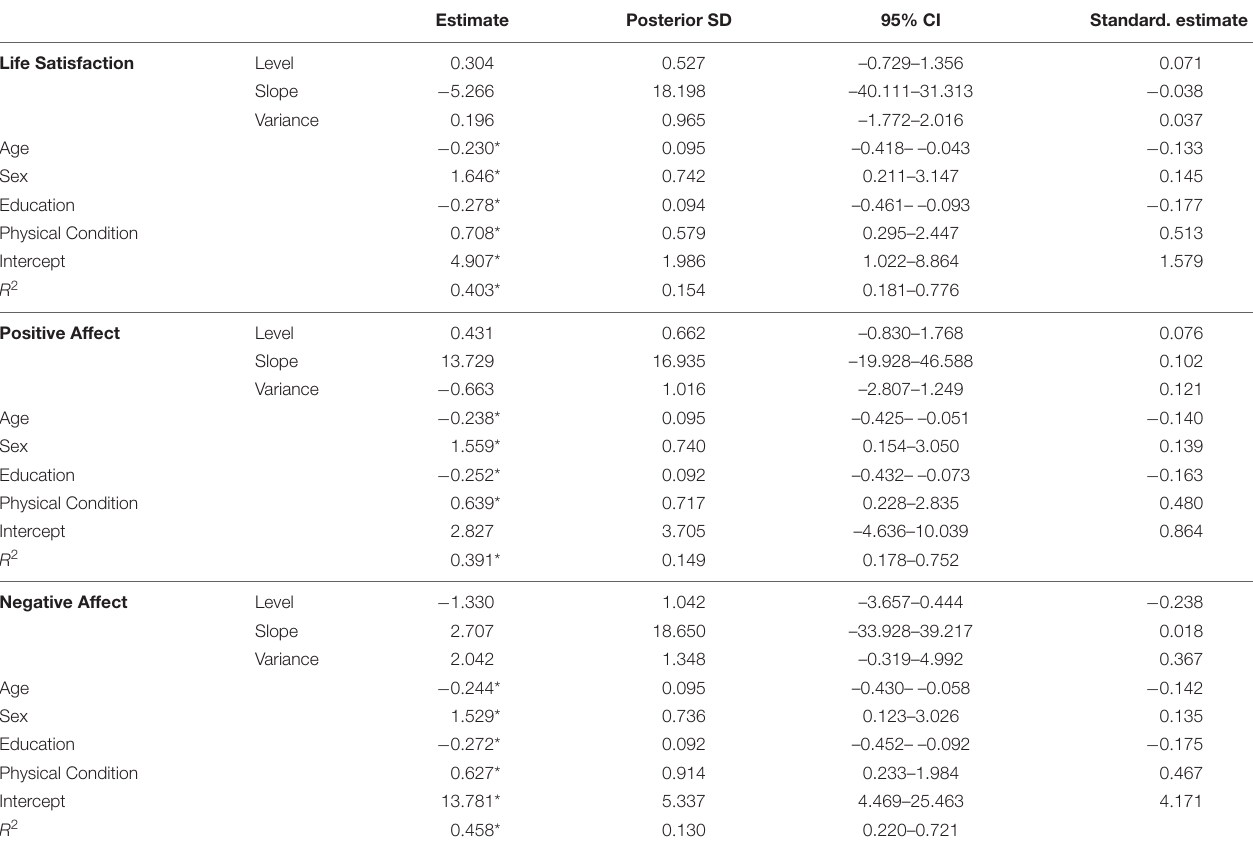
TABLE 4 | Multilevel SEM between-person regressions of time-to-death at baseline on life satisfaction, positive affect, and negative affect. Estimate Posterior SD 95% CI Standard.